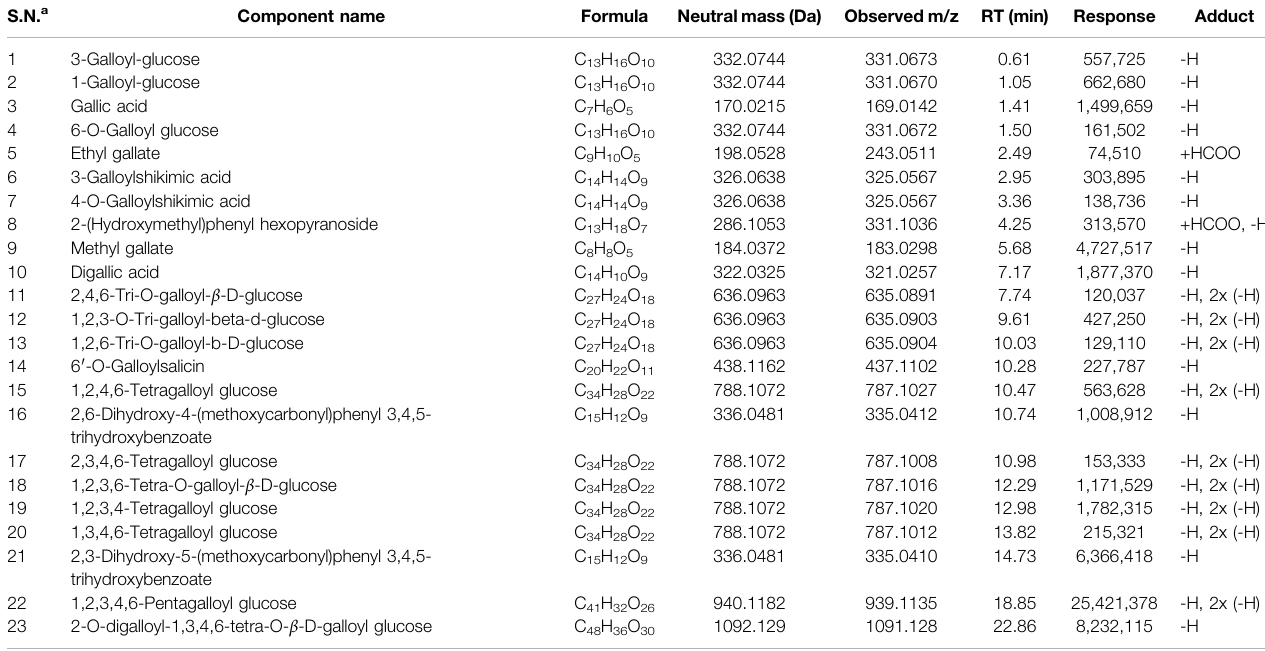
a S.N. represents the peak number depicted in the chromatogram ( Figure 5A ).